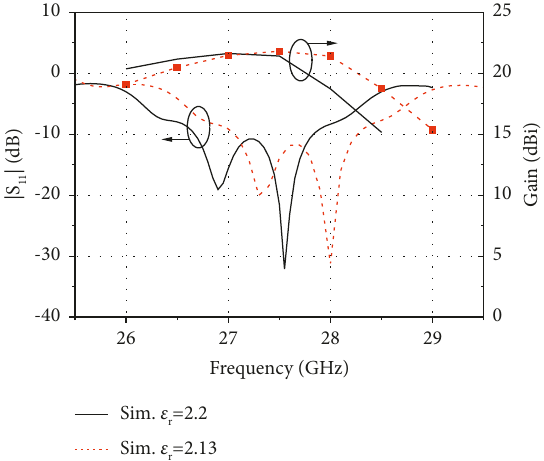
Figure 14: Simulated and measured | S antenna array.